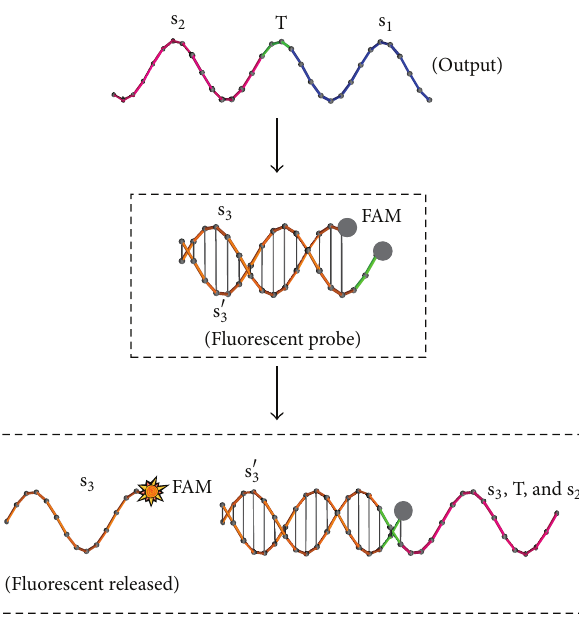
Figure 3: Fluorescent probe is set for reporting the output in qRT-